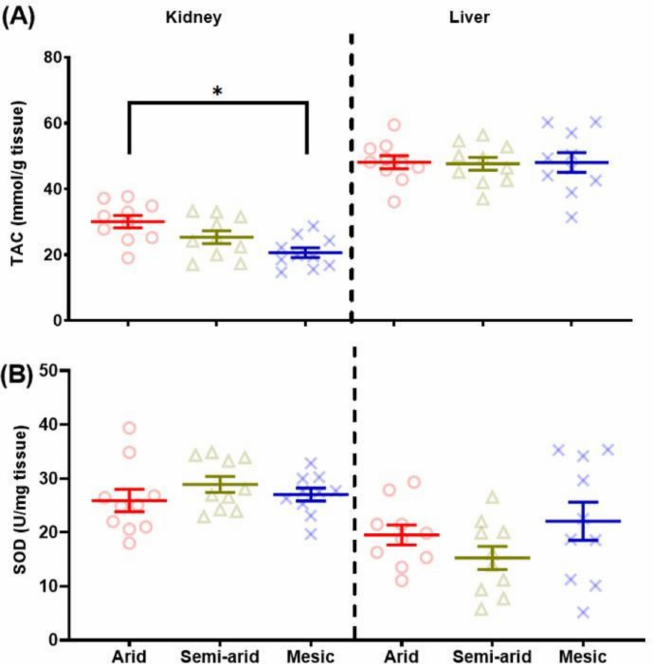
Figure 3. Kidney and liver ( A ) non-enzymatic total antioxidant activity (TAC—mmol/g tissue) and ( B ) enzymatic antioxidant activity through superoxide dismutase (SOD—U/mg tissue) of the common mole-rat ( Cryptomys hottentotus hottentotus ) for each population along an aridity gradient (arid—red (circles), semi-arid—moss (triangle), mesic—blue (x)). Mean ± s.e.m. An asterisk (*) indicates significance ( p ≤